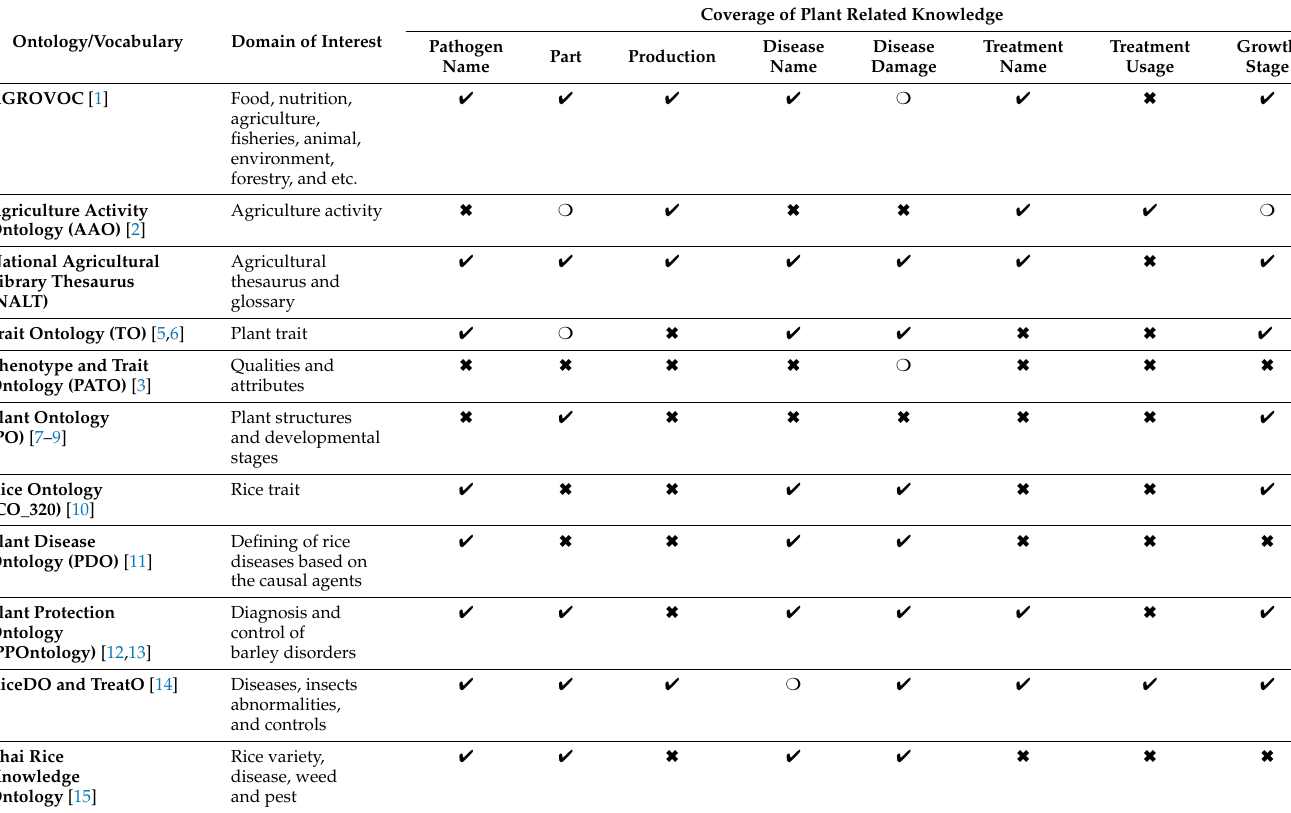
Table 1. Existing, relevant ontologies and vocabularies in the agriculture domain †